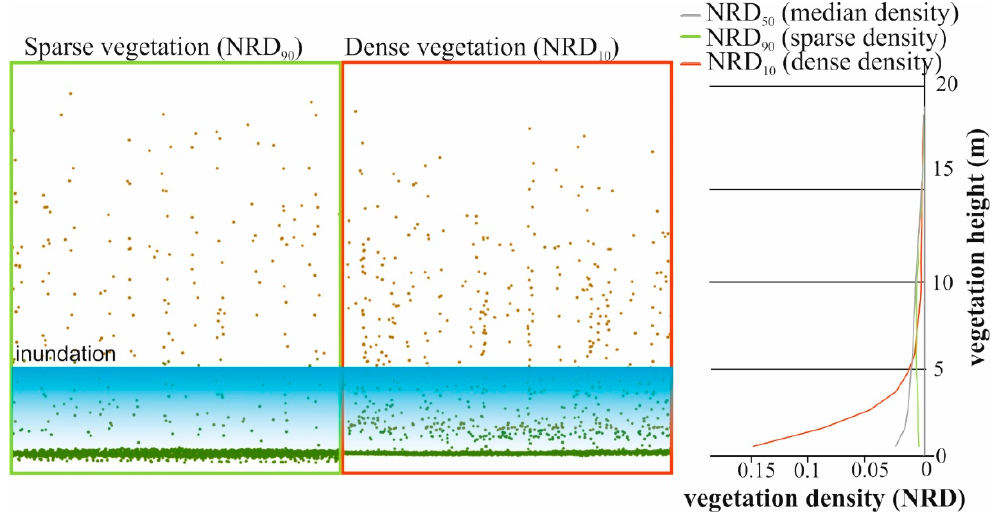
Figure 7. LiDAR point distribution in voxels with sparsely and densely vegetated mature poplar plantations, and characteristic vertical distribution of their vegetation density.